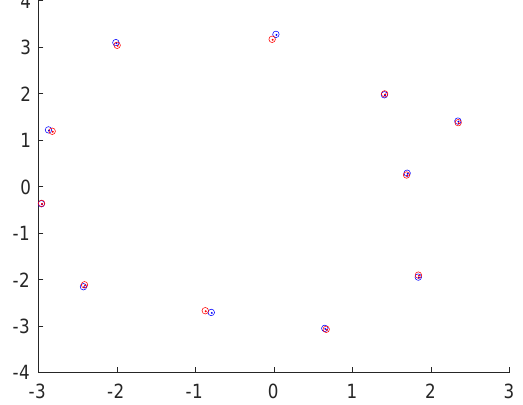
Figure 16. Birdeye view onto the environment with estimated (red) and groundtruth (blue) locations of the objects using the approach of Lan et al. [51]. Dataset: rm4. Unit: